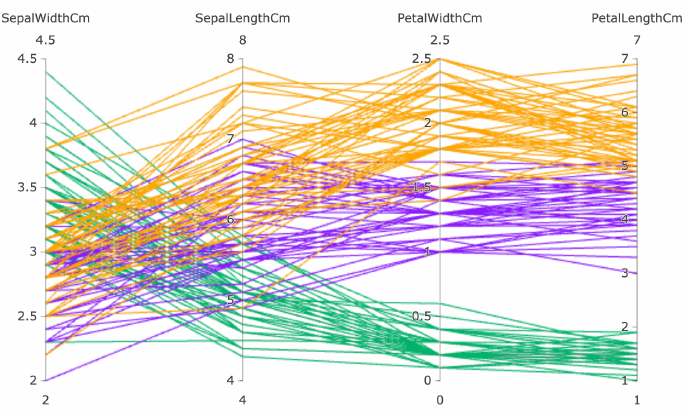
Figure 4. Feature View: PCP showing the relationship among various features of instances in the Iris